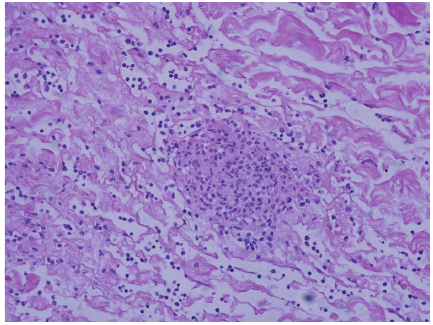
F 6: Pathology specimen demonstrating granulomatous tenosynovitis with acid fast bacilli.